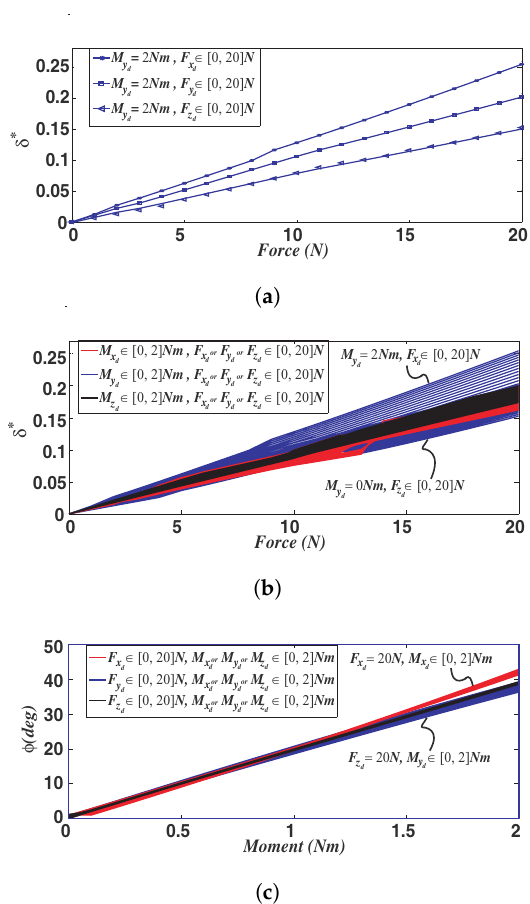
Figure 7. The variation of total parasitic displacement and desired rotation for different loading cases: ( a ) dimensionless total displacement variation for M y F z ); ( b ) dimensionless total displacement variation for different loading cases in terms of applied force; d ( c ) rotation variation for different loading cases in terms of applied